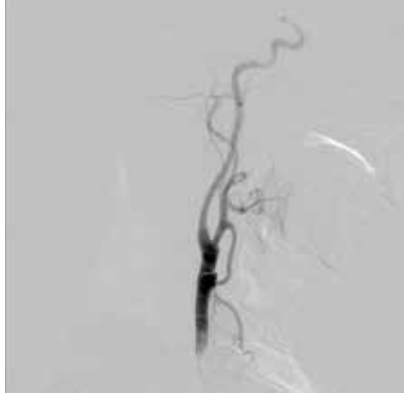
Figure 10 Angiography of the right common carotid artery following injury; uneven thickness of the right common carotid artery with